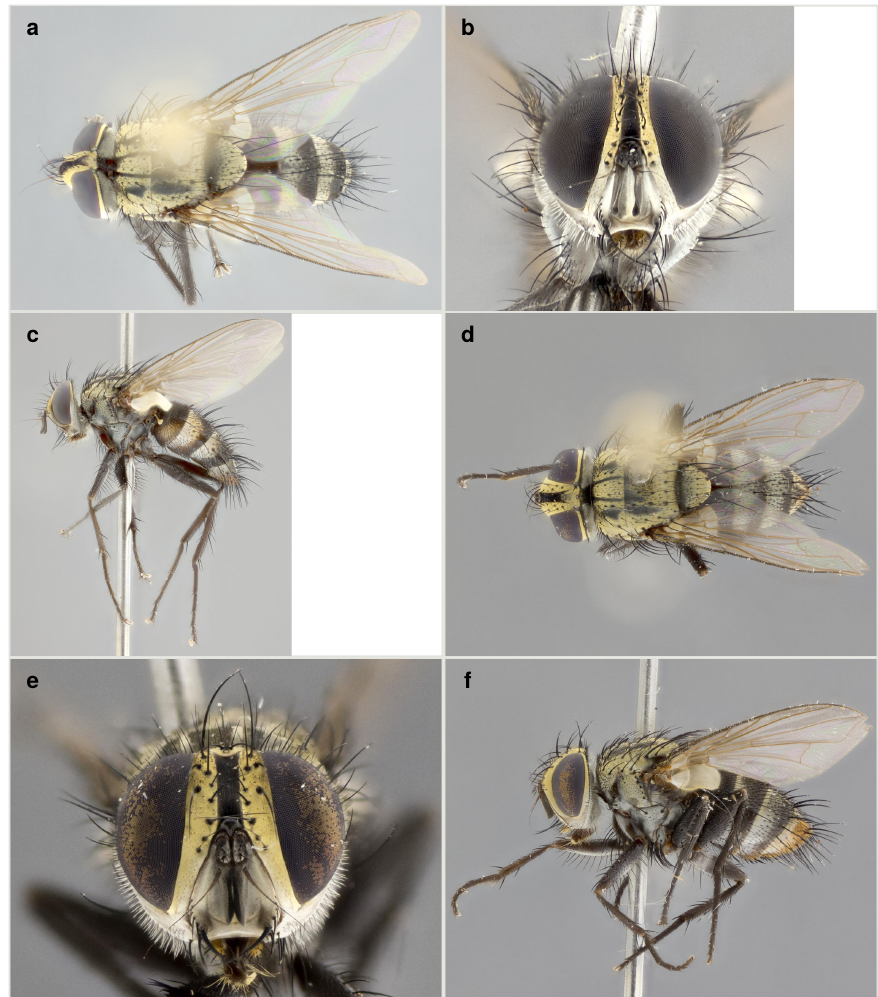
Vibrissina robertwellsi sp. n. a–c : holotype male, voucher code: DHJPAR0017875; d–f : paratype female, voucher code: